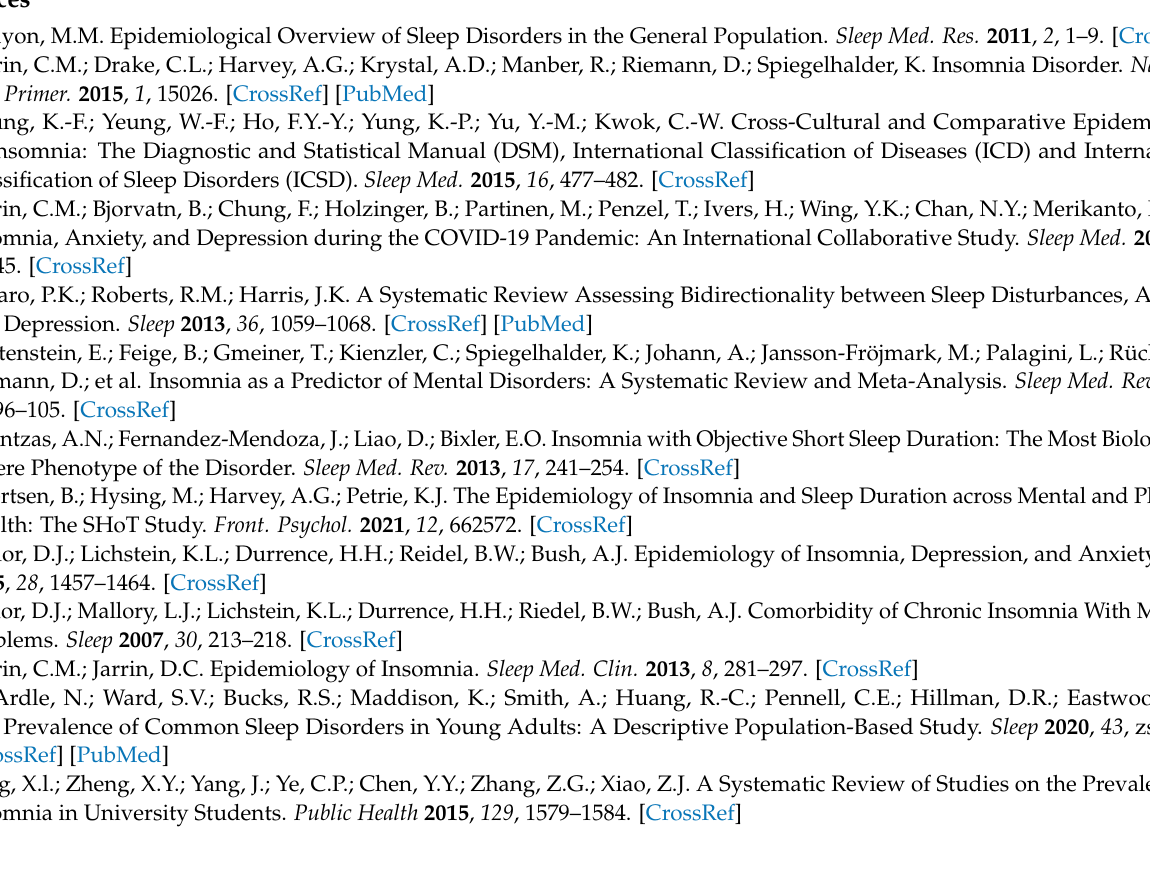
Note . SI, severe insomnia subgroup; MI-MU, moderate insomnia with medication use subgroup; SubI, subthreshold insomnia subgroup; SubI-SL, subthreshold insomnia with sleep latency complaints subgroup; MI-SD, moderate insomnia with sleep duration complaints subgroup; BMI, body mass